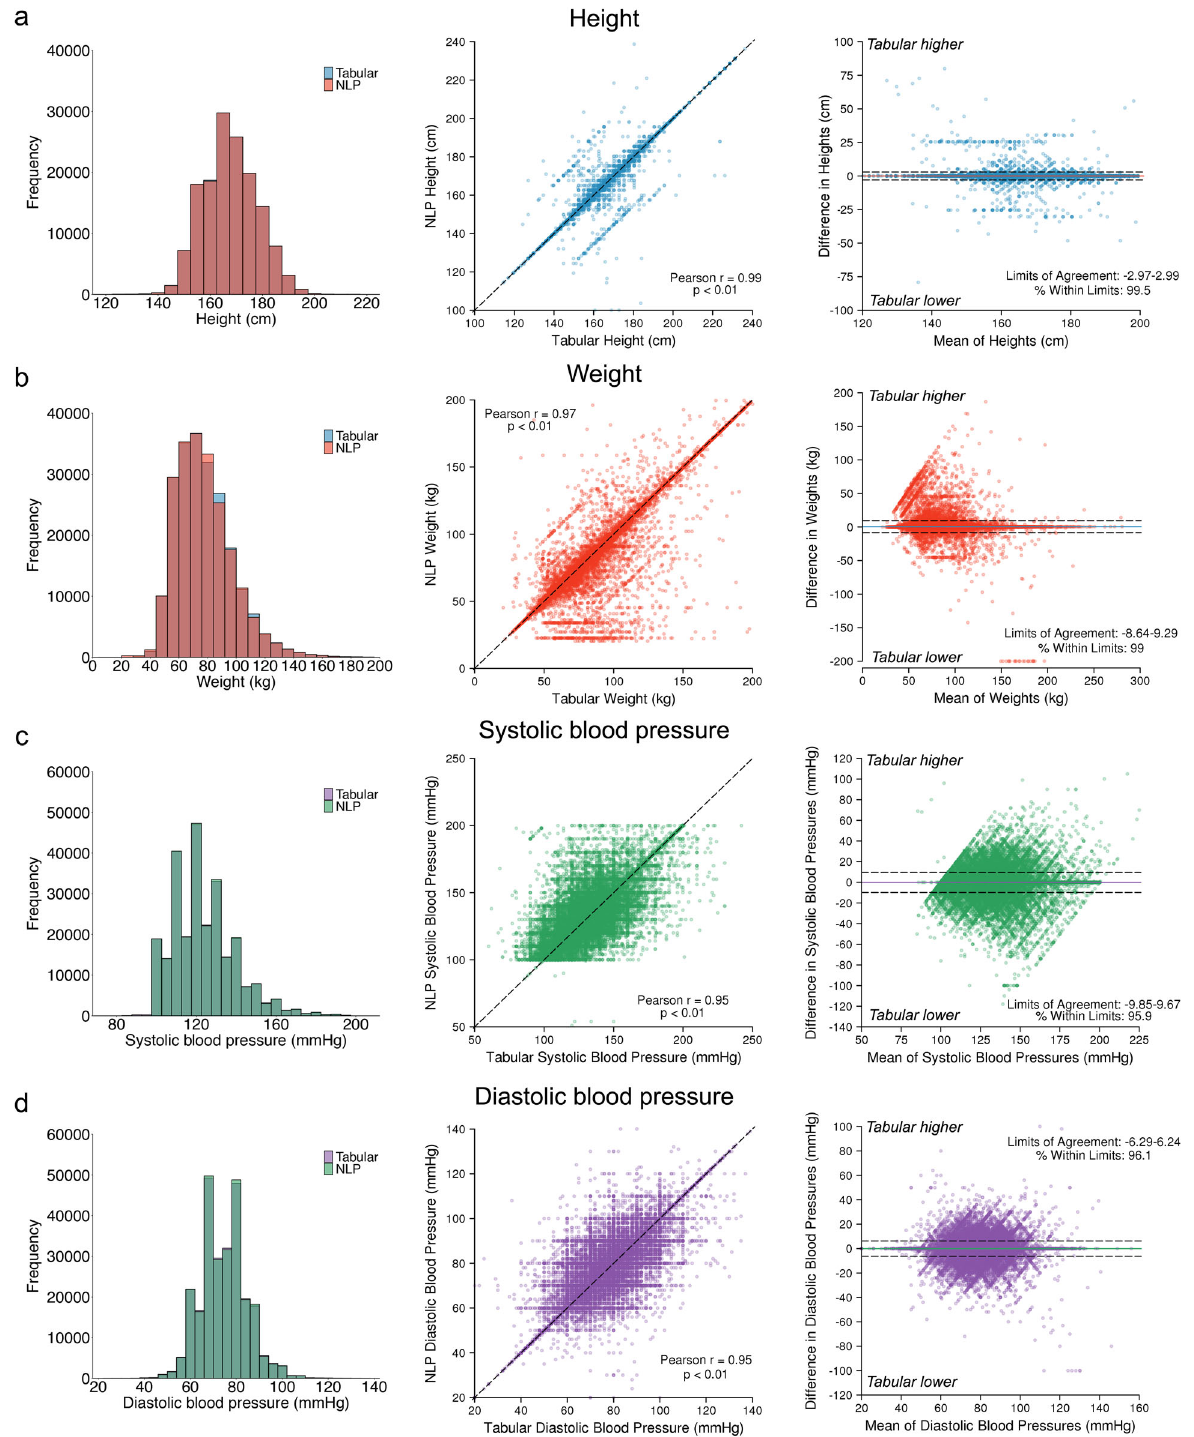
Fig. 4 Agreement between tabular and natural language processing-extracted vital signs. Depicted is agreement between vital signs obtained from tabular data and those obtained from our NLP model among individuals with values obtained on the same day. a Depict height values, b depict weight values, c depict systolic blood pressures, and d depict diastolic blood pressures. For individuals with multiple eligible values, only the pair most closely preceding the start of follow-up was used. Left panels show the distribution of values obtained from tabular versus NLP sources. Middle panels show the correlation between tabular values ( x -axis) and NLP values ( y -axis). Right panels are Bland – Altman plots showing agreement between paired tabular and NLP values. The x -axis depicts the increasing mean of the paired values, and the y -axis depicts the difference between the paired values, where positive values denote tabular values greater than corresponding NLP values and negative values denote tabular values lower than corresponding NLP values. The colored horizontal lines depict the mean difference between sources, and the hashed horizontal lines depict 1.96 standard deviations above and below the mean. The values corresponding to the bounds and percentage of values contained within those bounds is printed on each